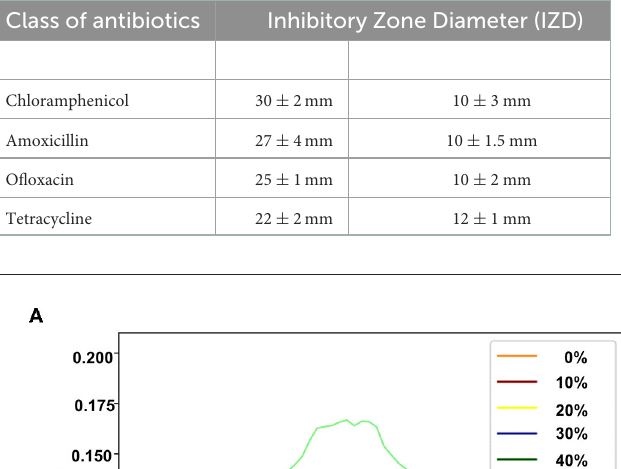
TABLE 2 Diameter of the bacteriostatic circle in different antibiotics. Class of antibiotics